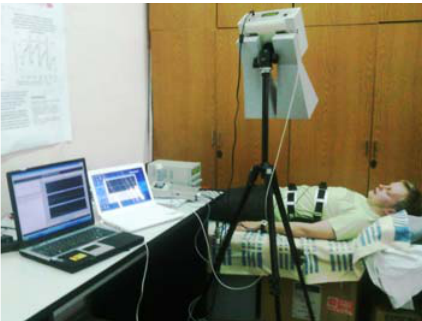
Figure 1: Simultaneous registration of BRL and RPG signals during the experiment.